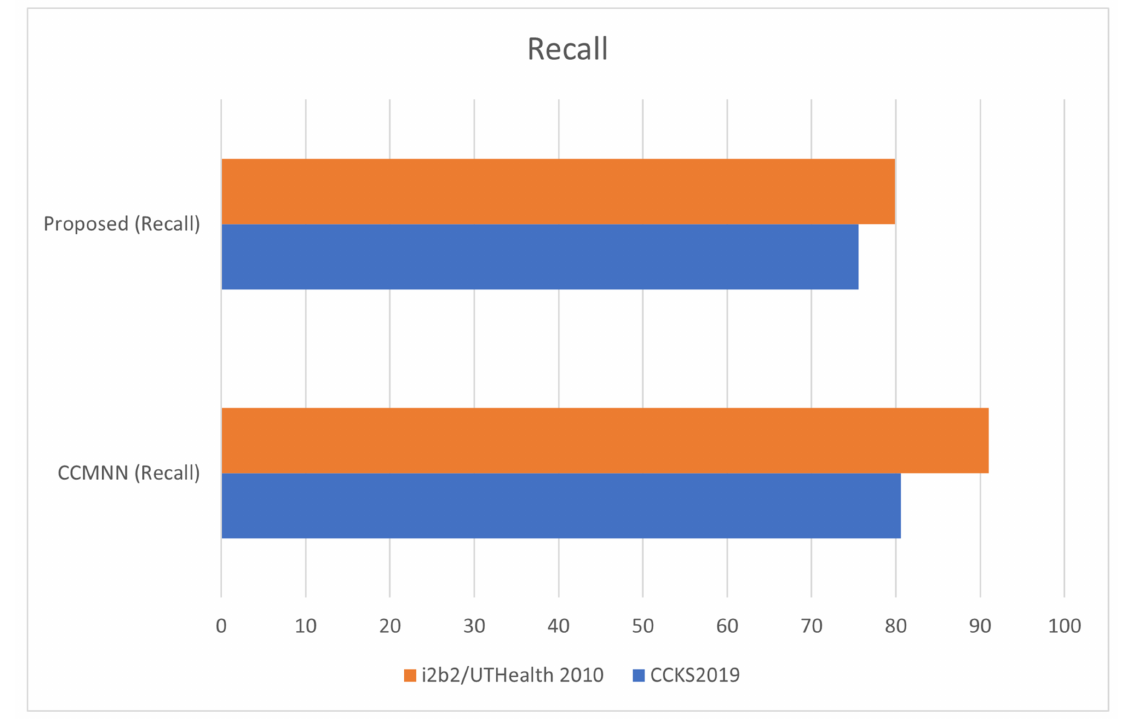
Figure 5. Measuring Recall in Clinical Record Analysis with the I2B2/UTHEALTH 2010